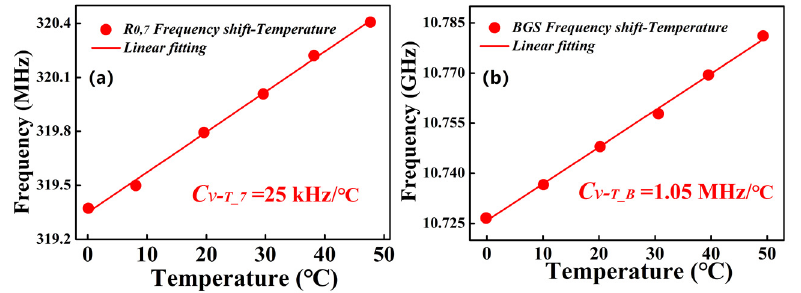
Figure 8. Frequency shift for ( a ) R 0,7 -induced FBSS and ( b ) BGS as a function of temperature.